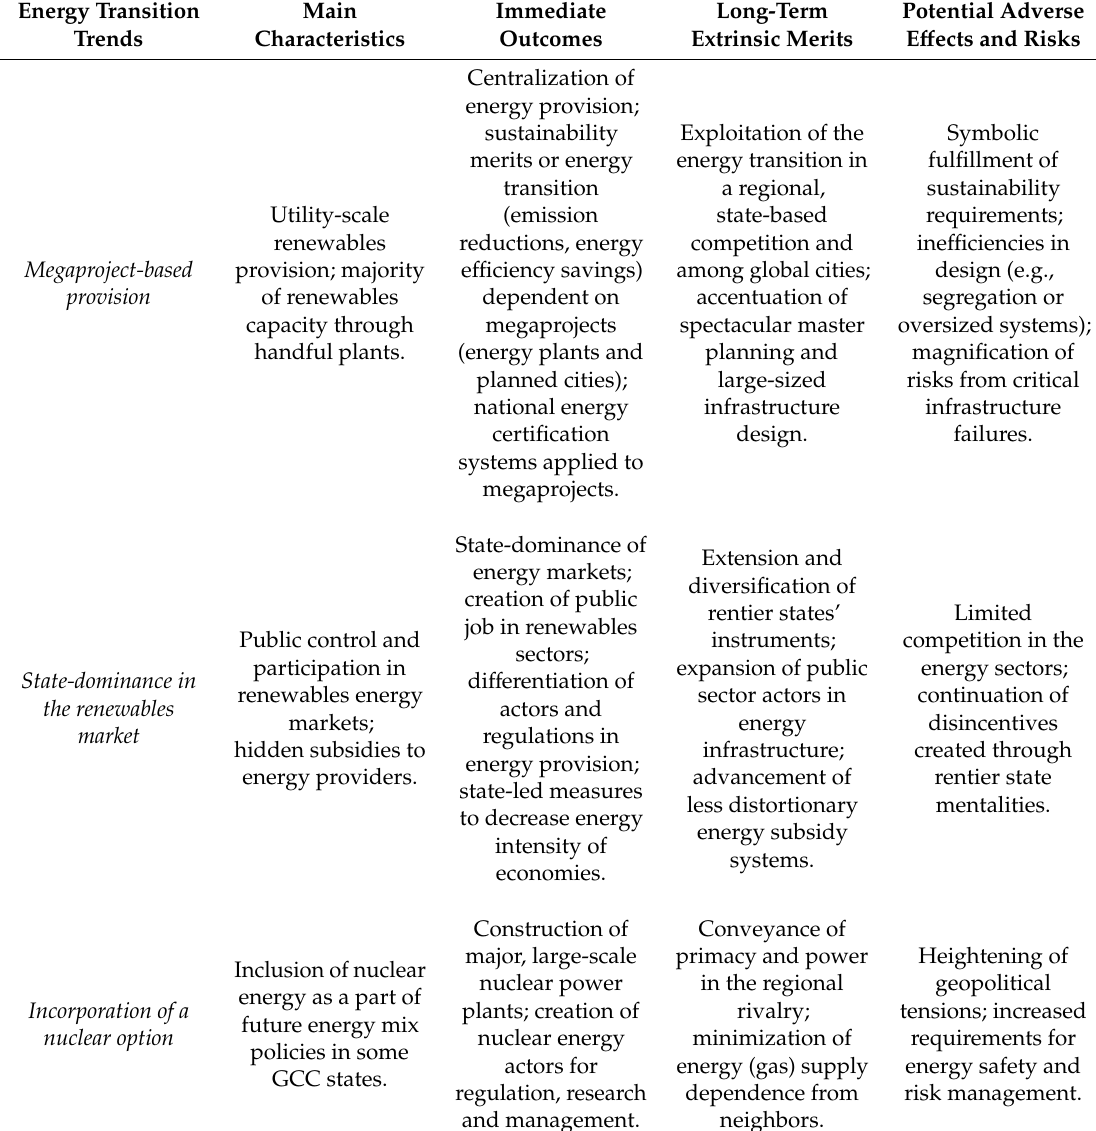
Table 4. Summary of the analyzed energy transition trends and potential